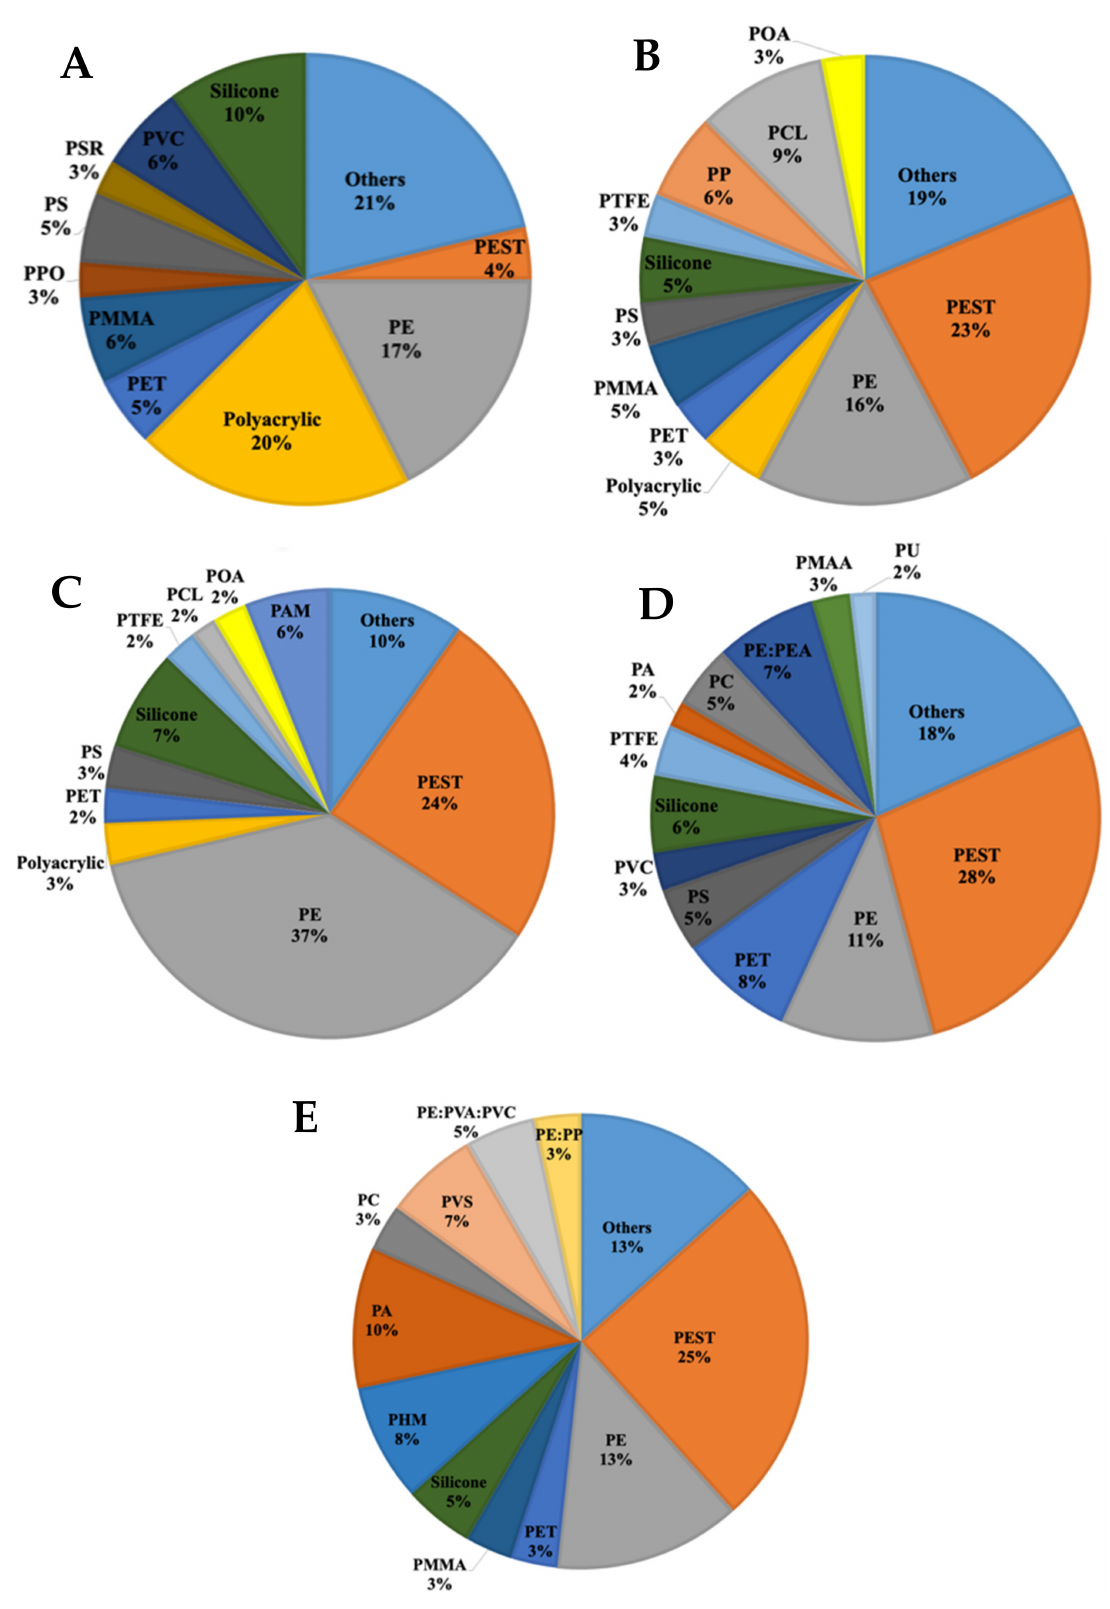
Figure 4. Composition of polymers detected in Wellsgate Lake water ( A ), wastewater stabilization pond water ( B ), treated effluent ( C ), sludge ( D ), and duckweed ( E